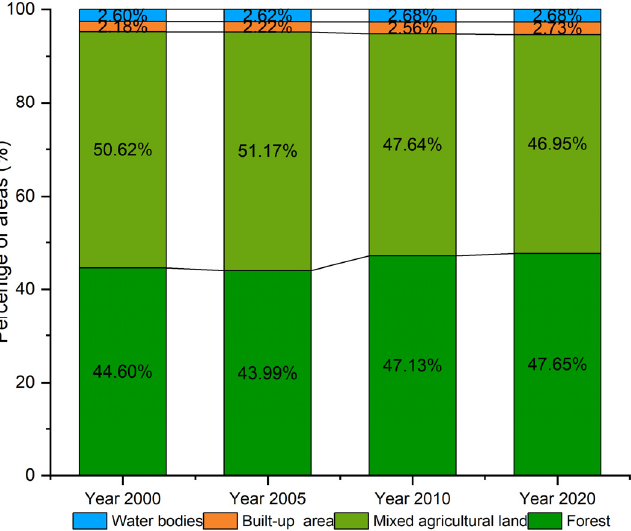
Figure 3. The distribution (%) of different land-use classes in the study area for the studied years in Da Nang city and Quang Nam province.